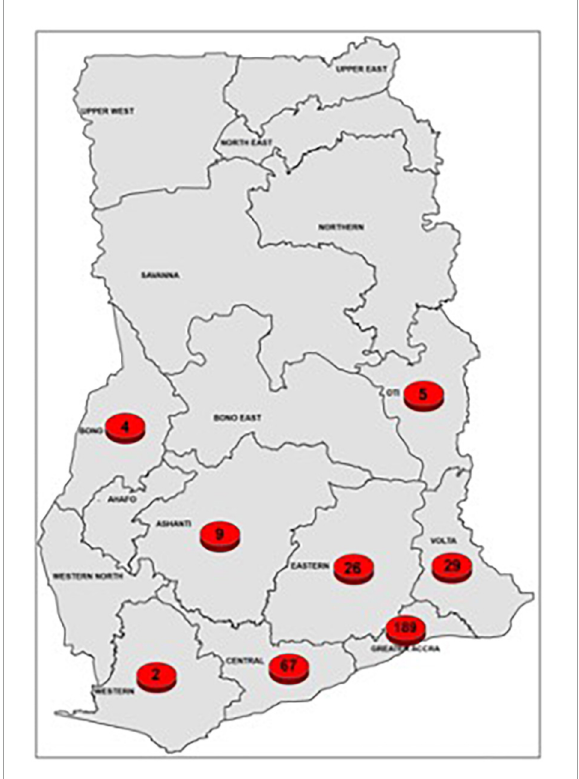
FIGURE1 Regional distribution of recruited patients for the